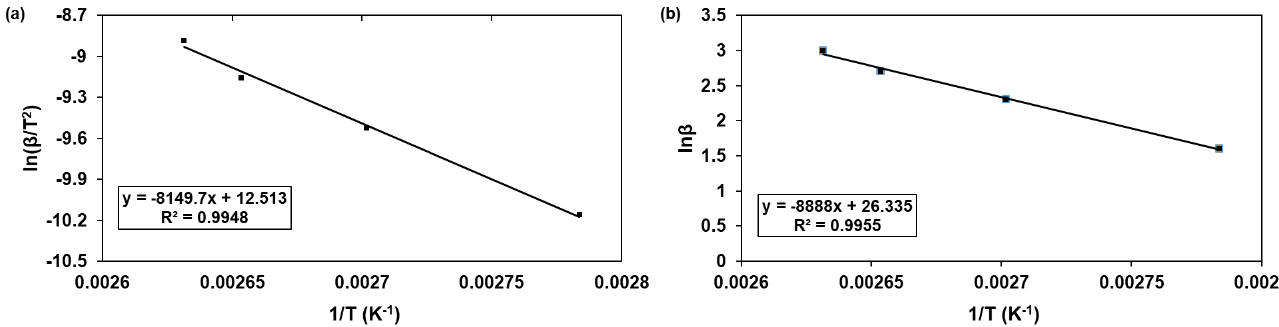
Figure 3. ( a ) Kissinger plot and ( b ) Ozawa plot of epoxy/thiol/MI system. ln ( 𝛽 𝑇 𝑝2 ) = ln ( 𝐴𝑅 𝐸 𝑎 ) − 𝐸 𝑎 𝑅𝑇 𝑝